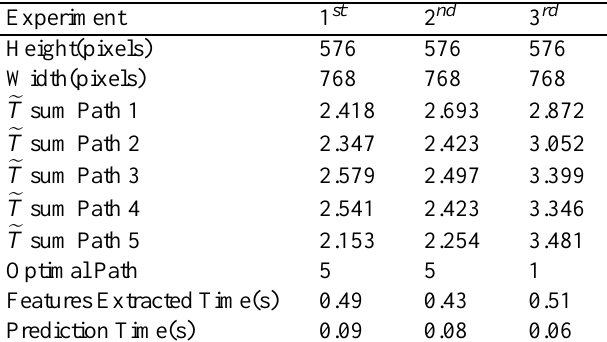
Fig. 19. The T distribution of optimal path of the experi- ment 3. e